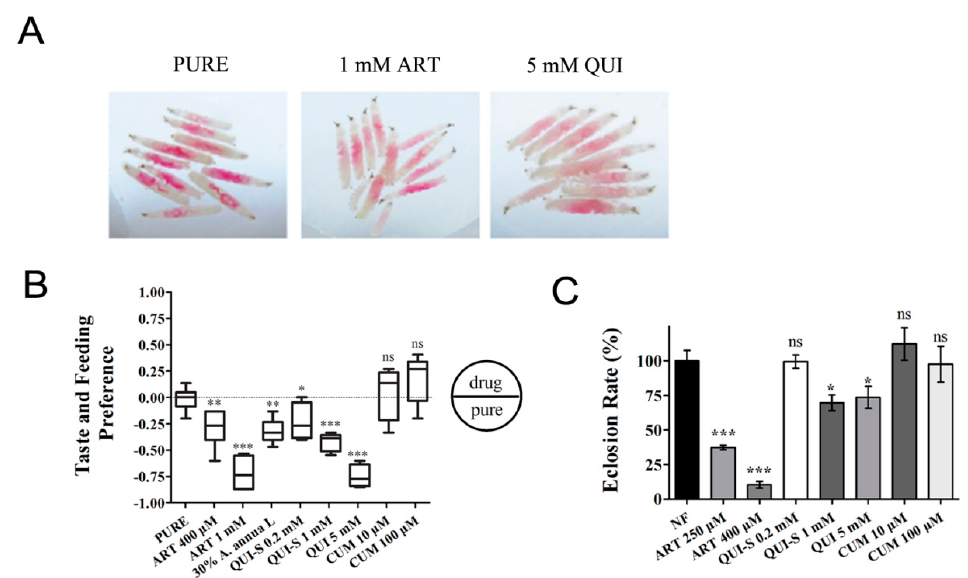
Figure 3. ART is a weak antifeedant but possesses a distinct insecticidal activity. The feeding tendency of Drosophila larvae on different natural compounds is shown. ( A ) Larvae feeding assay. Larvae are allowed to feed on either a red − dyed plate or a red − dyed plate with ART or QUI, for 15 min. Larvae ate less in ART − or QUI − added food, as indicated by the intensity of the dye in the gut. n ≥ 3. ( B ) Larvae feeding tendency assay. Early 3rd instar larvae were allowed to freely choose between the two sides of a petri dish containing 1% agarose with or without the drugs: artemisinin (ART), quinine (QUI), quinine sulfate dihydrate (QUI − S), and curcumin (CUM). DMSO was used as a control (PURE). A feeding preference index was calculated to indicate the tendency of larvae toward the compound. n ≥ 10. ( C ) The eclosion rate of flies on different drugs. These data show that under these concentrations, ART is a weaker antifeedant but a much stronger insecticide. The files were kept at 29 °C. *** p < 0.001, ** p < 0.01, * p < 0.05. ns, no significance.